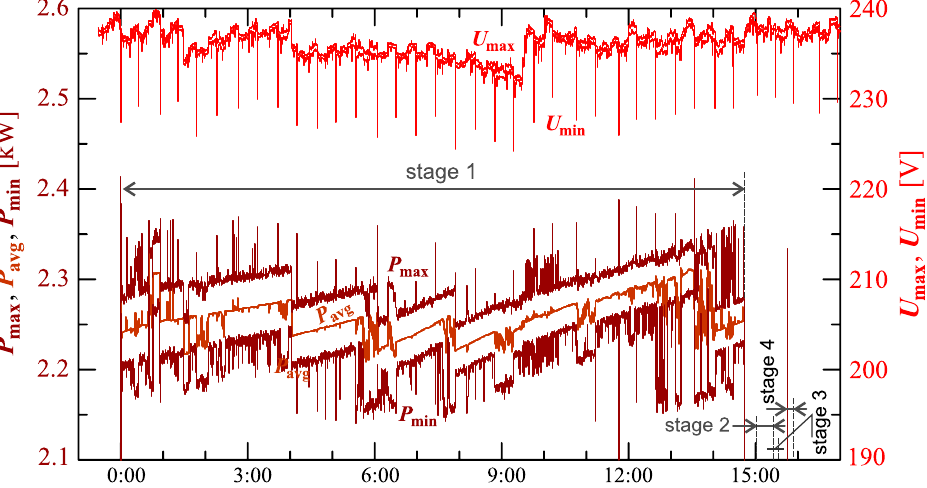
Figure 30. The characteristic of maximum P max = f ( t ) , average P avg = f ( t ) and minimum P min = f ( t ) values of active power and maximum U max = f ( t ) and minimum U min = f ( t ) rms values of supply voltage for Case